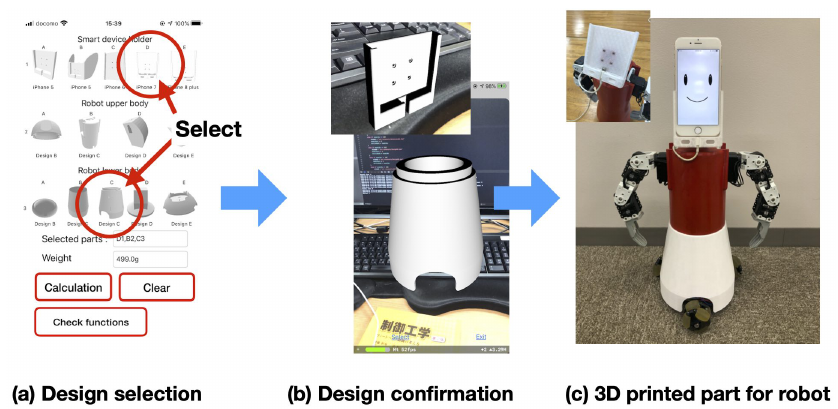
Figure 5. Hardware confirmation and selection system based on a smart